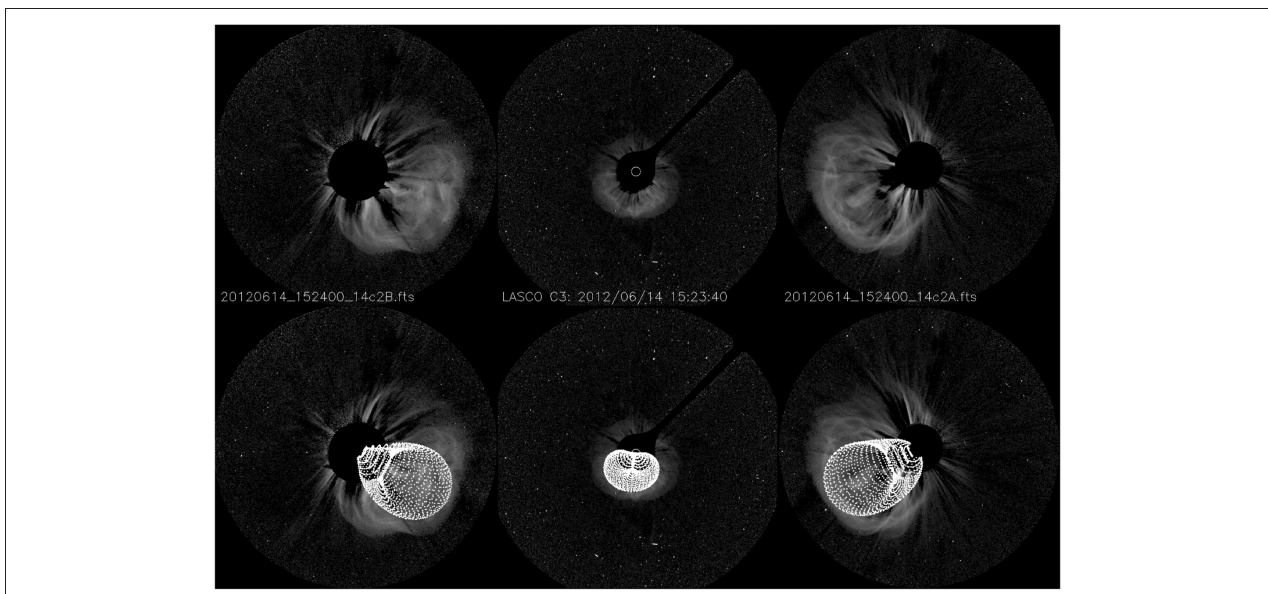
FIGURE 2 | Example of GCS fitting of CME3 using images at 15:24 UT from STEREO/SECCHI/COR2-B (Left) , SOHO/LASCO/C3 (Middle) , and STEREO/SECCHI/COR2-A (Right) .